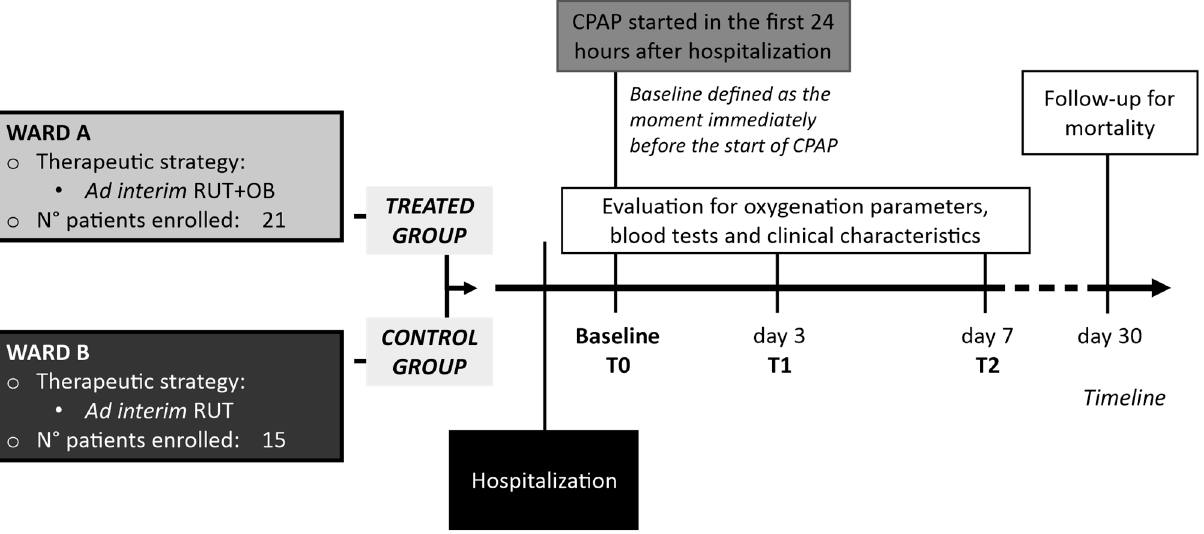
Figure 1. Schematic representation of the study design.